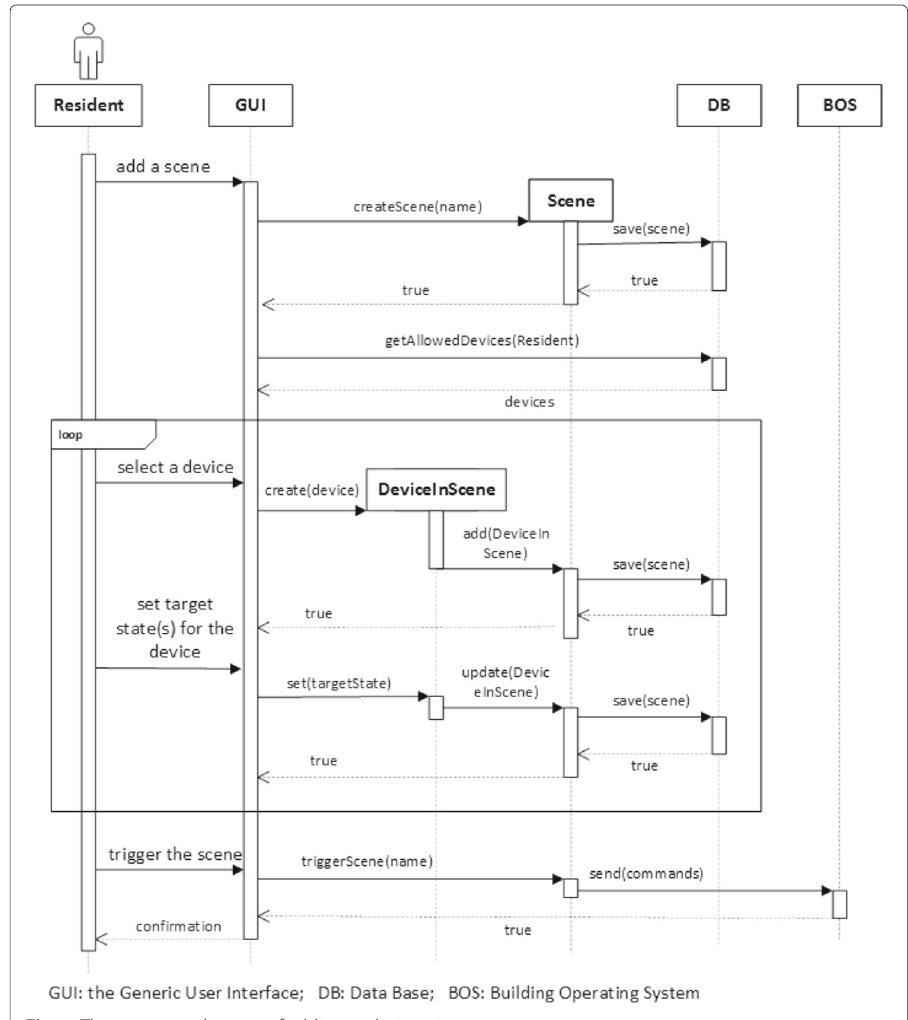
Fig. 7 The sequence diagram of adding and triggering a